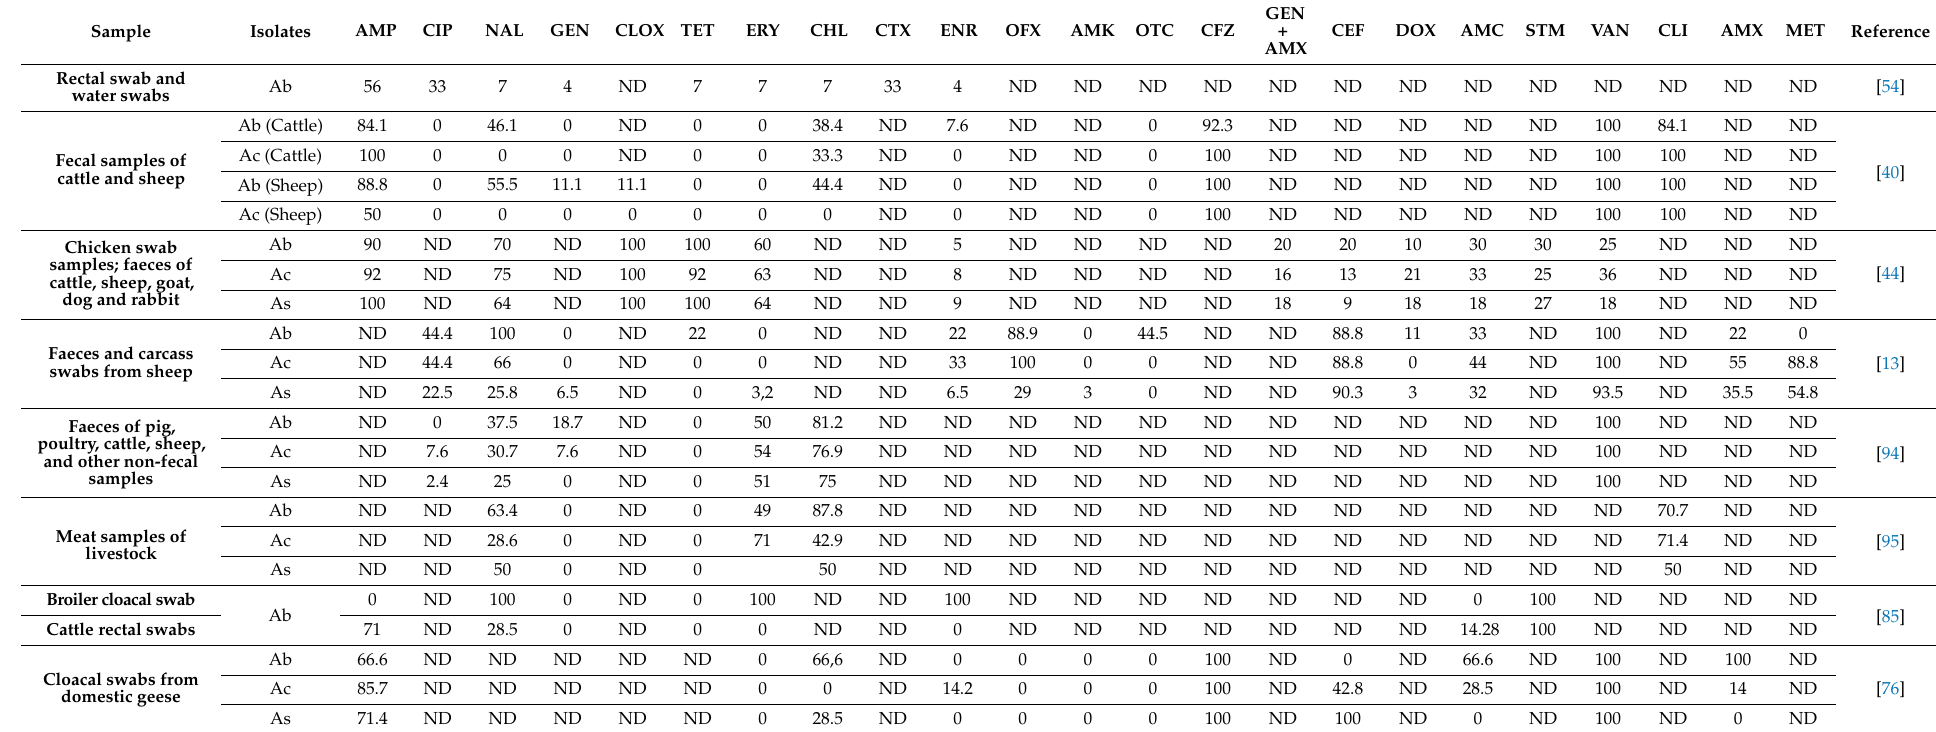
Table 2. Aliarcobacter antibiotic resistance rates in percentages in farm animals over the past